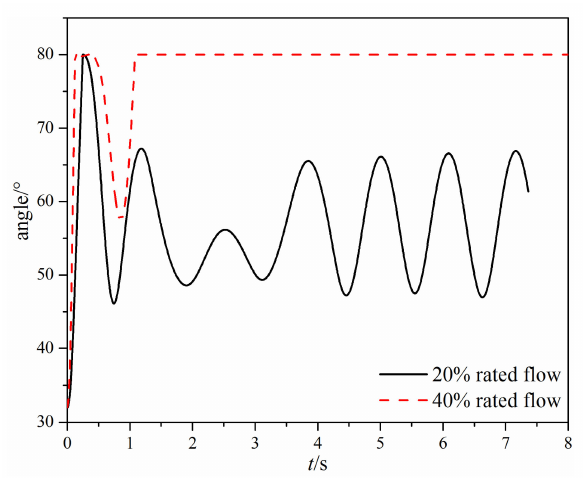
Figure 12. The time-varying opening angle under di ff erent mass flow